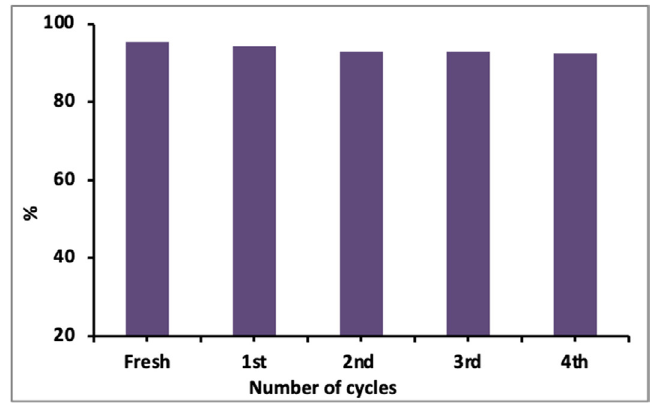
Fig. 12. Recyclability of CeO